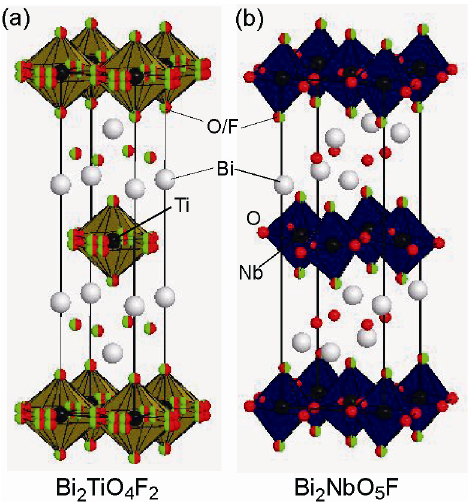
TiO F , and ( b ) Bi 2 4 2